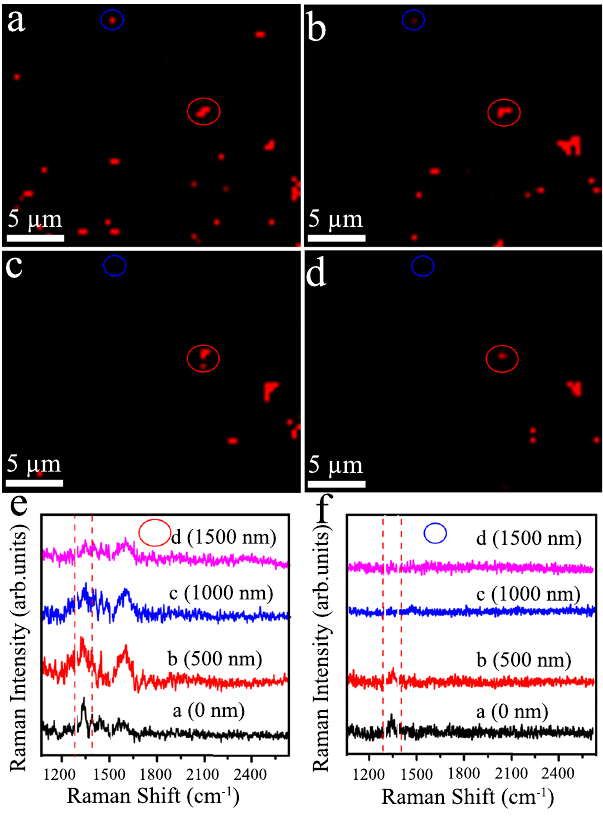
Fig. 3 Study of confocal height on Raman signal intensity. SERS mapping of FGF-2 SERS nanotags on the silicon substrate with changing confocal height of a 0 nm, b 500 nm, c 1000 nm, and d 1500 nm; selected Raman spectra obtained from e red circles and f blue circles of SERS images. Red dotted lines in e and f indicate peak signal at 1330 cm − 1 from DTNB. Data from one independent experiment. Source data are provided in the Source Data fi